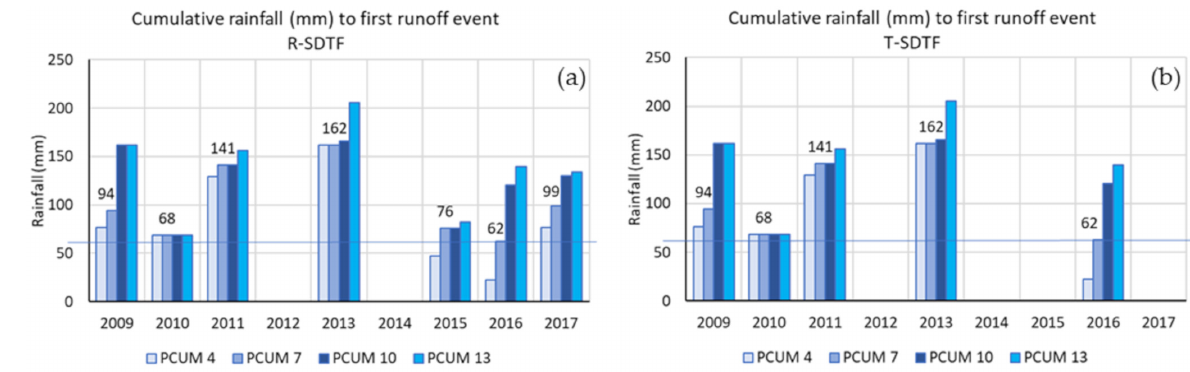
Figure 7. Rainfall characteristics to first runoff event (2009-2017): ( a ) R-SDTF; ( b )